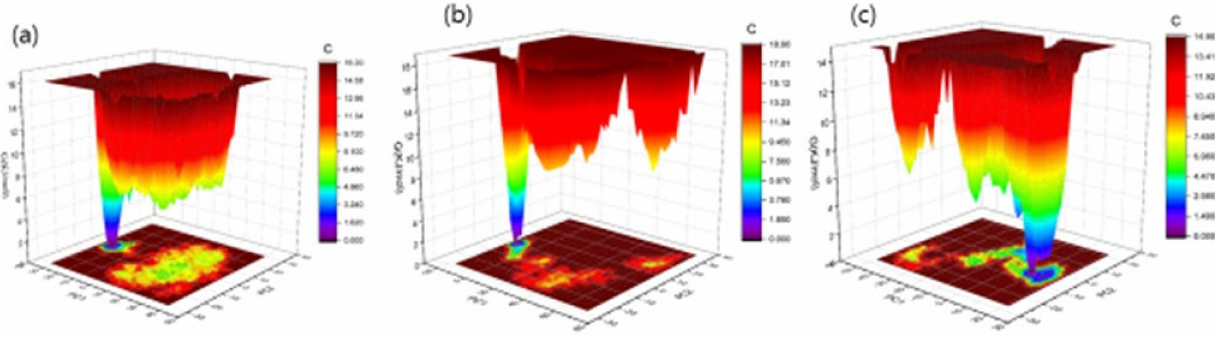
Figure 11. The Gibbs free energy landscape of complexes. The OmpU-control compound ( a ), OmpU-ZINC95910434 ( b ), and OmpU-ZINC06494587 ( c